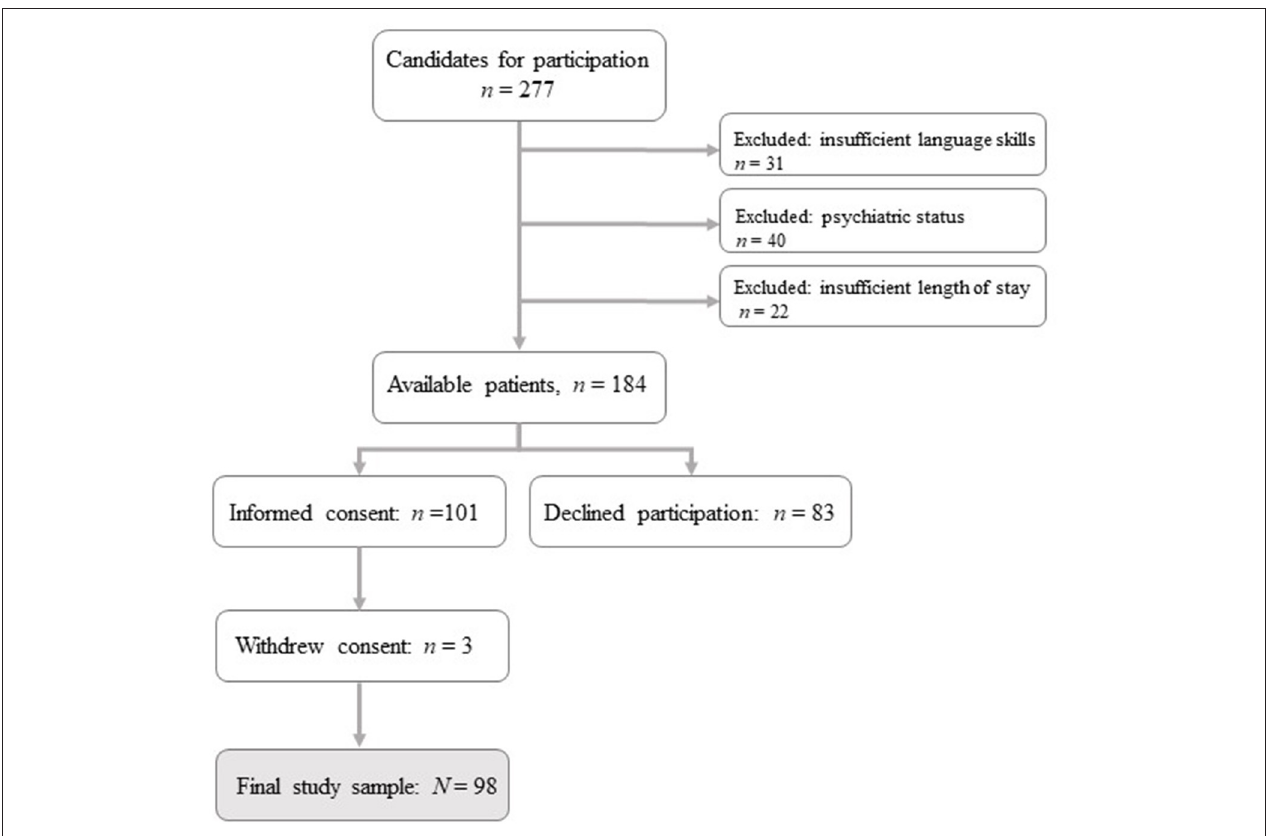
FIGURE 1 | Flowchart for inclusion of